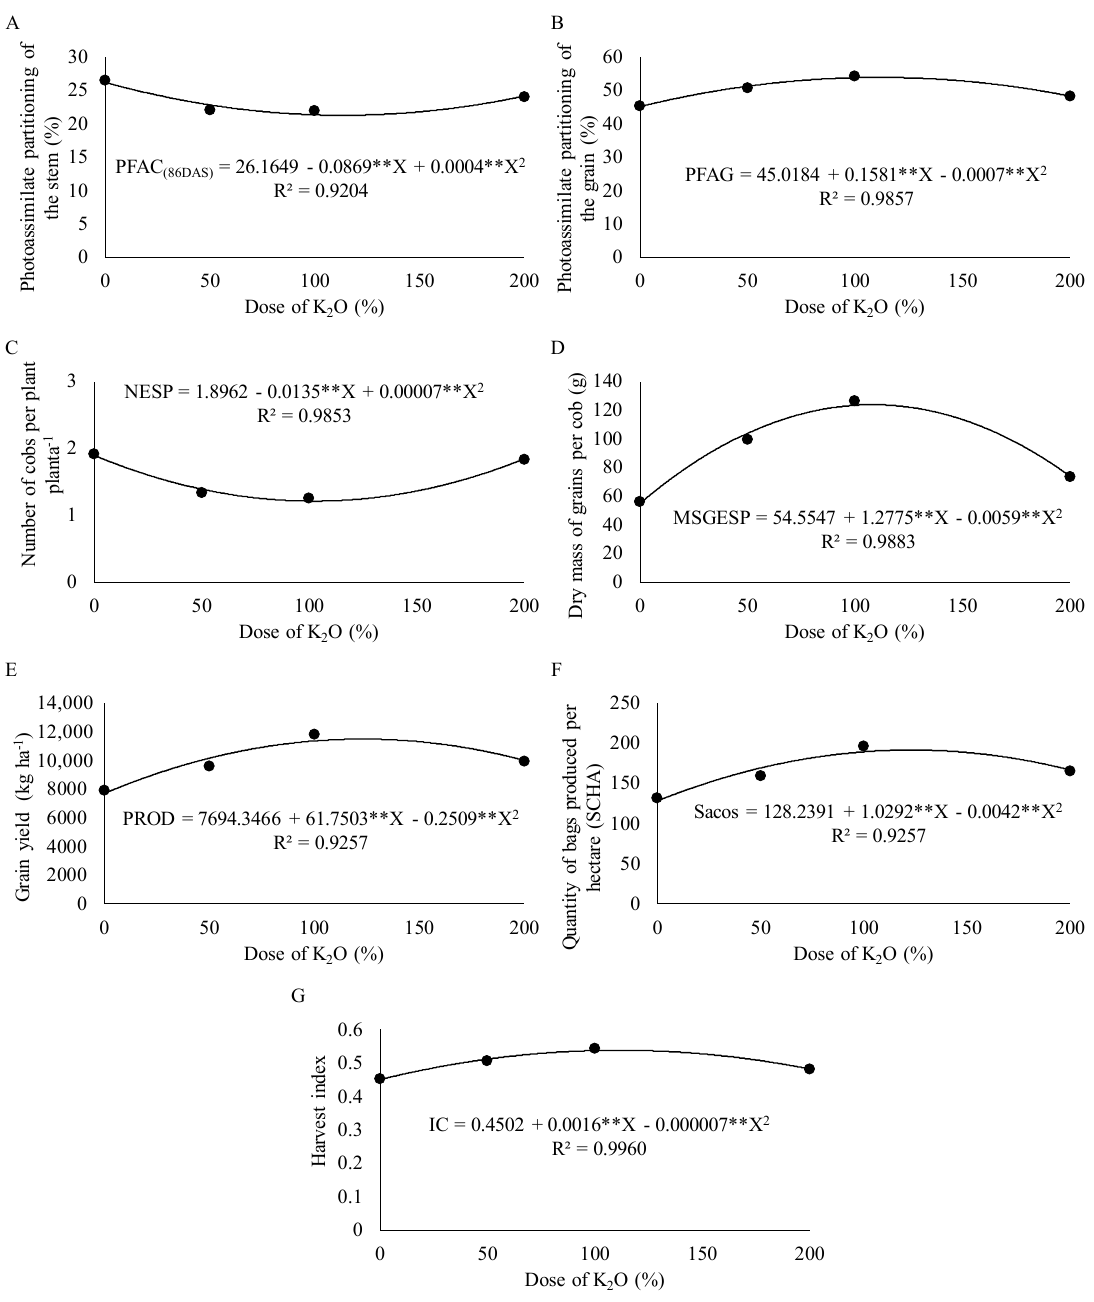
Figure 3. Photoassimilate partitioning of stem (PFAC) ( A ) and grains (PFAG) ( B ), number of cobs per plant (NESP) ( C ), grain dry mass er cob (MSGESP) ( D ), grain yield (PROD) ( E ), number of bags produced per hectare (SCHA) ( F ), and harvest index ( G ) of corn as a function of potassium doses. Rio Verde, Goias, 2019–2020 gowing season. ** and *: significant at 1% or 5% probability. In the present study, for the potassium chloride source, the MET and MEE were achieved at the estimated the doses of 120.27% and 116.76%, corresponding to 108.24 and 105.08 kg ha − 1 of potassium (K 2 O), respectively (Figure 4A). For the concentrated vinasse source, the MET and MEE were achieved at the estimated doses of 139.18% and 139.17%, corresponding to 125.26 and 125.25 kg ha − 1 of potassium, respectively (Figure 4B). However, at these doses, PROD obtained using the potassium chloride source was 28% higher than that obtained using the concentrated vinasse source.